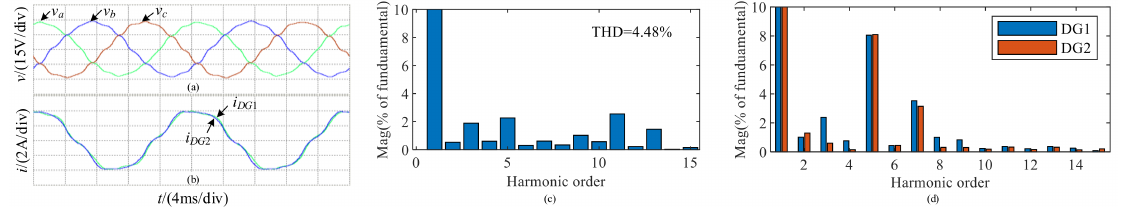
Figure 16. The experimental results of the method proposed under the mixed load connected to the PCC: ( a ) PCC voltage; ( b ) Phase A output current of DGs; ( c ) FFT analysis of phase A voltage of PCC; ( d ) FFT analysis of phase A output current of DGs.